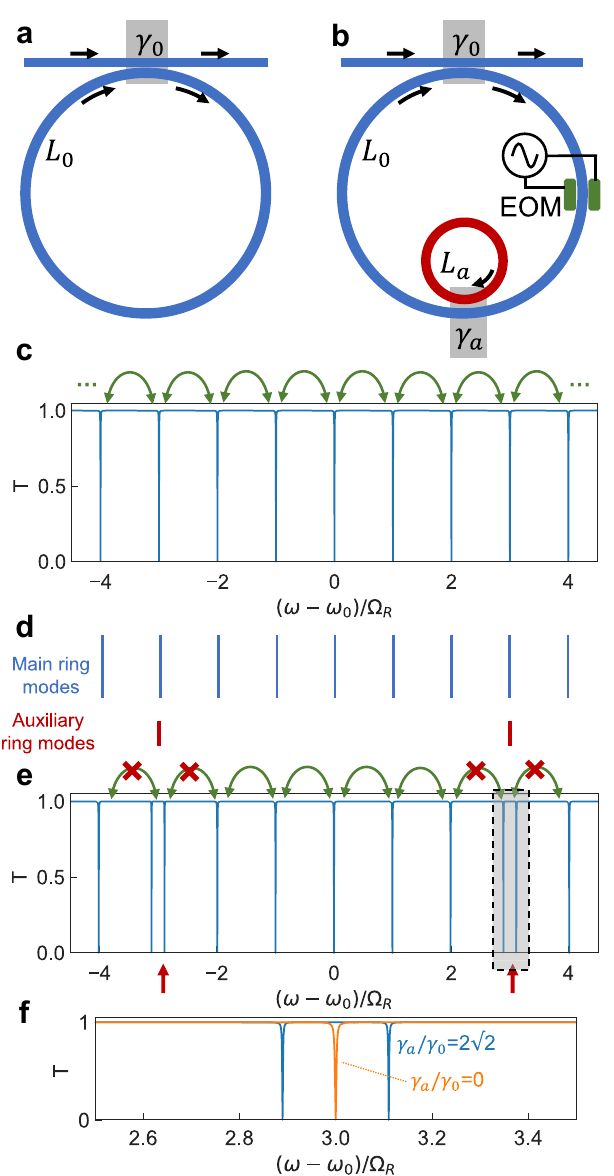
Fig. 1 Ring resonator and its transmission spectrum with and without an auxiliary ring. Schematic of a static ring resonator ( a ) and its simulated transmission T ( c ). The frequencies of the ring's modes are indicated in ( d ) with blue lines. b Ring with a coupled auxiliary resonator (red), and its corresponding transmission spectrum in the absence of modulation ( e ). The frequencies of the auxiliary ring's modes are indicated in ( d ) with red lines. f Shows a zoom-in around the mode of the auxiliary resonator that is aligned to a mode of the main ring. c , e , f are calculated numerically using a scattering matrix method with a power splitting ratio of γ 2 illustrative purposes, a propagation loss rate α 0 in the main ring is chosen to critically couple it to the waveguide, exp ð(cid:2) α 0 L 0 Þ ¼ 1 (cid:2) γ 2 auxiliary ring is assumed to be lossless. The red crosses in ( e ) indicate that the modulation at the FSR cannot couple the split modes to the rest of the lattice as they are not aligned to the frequency grid of the main ring. EOM electro-optic